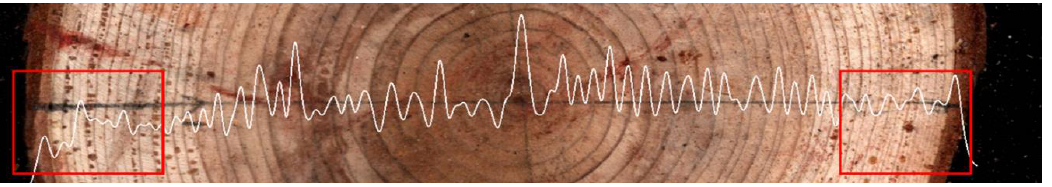
Figure 20. The analysis of filtered waveform and annual ring comparison of the fir #5 disk.